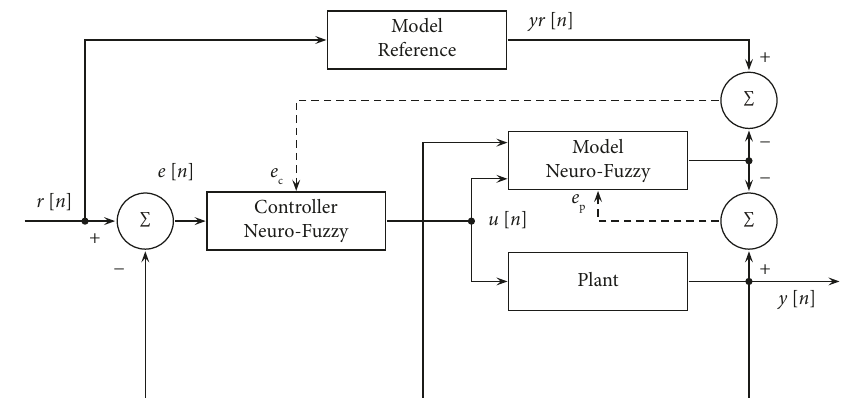
Figure 1: Control schemes using neuro-fuzzy systems.